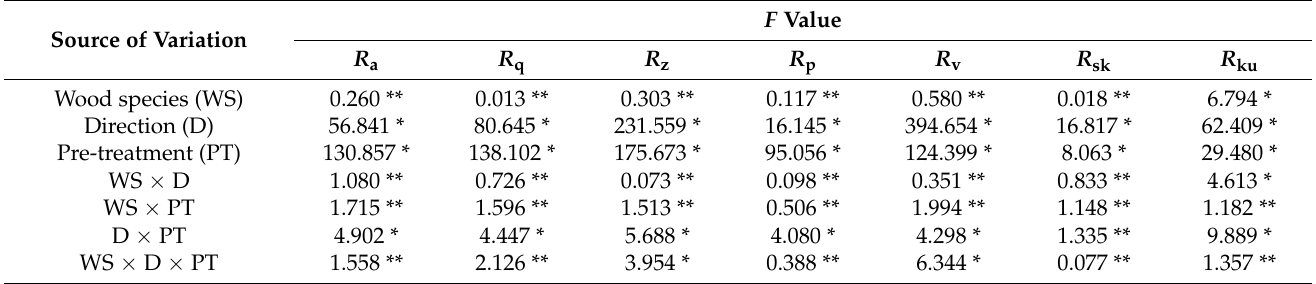
Table 1. Analysis of variance of surface roughness for sanded and thermally compressed veneers.